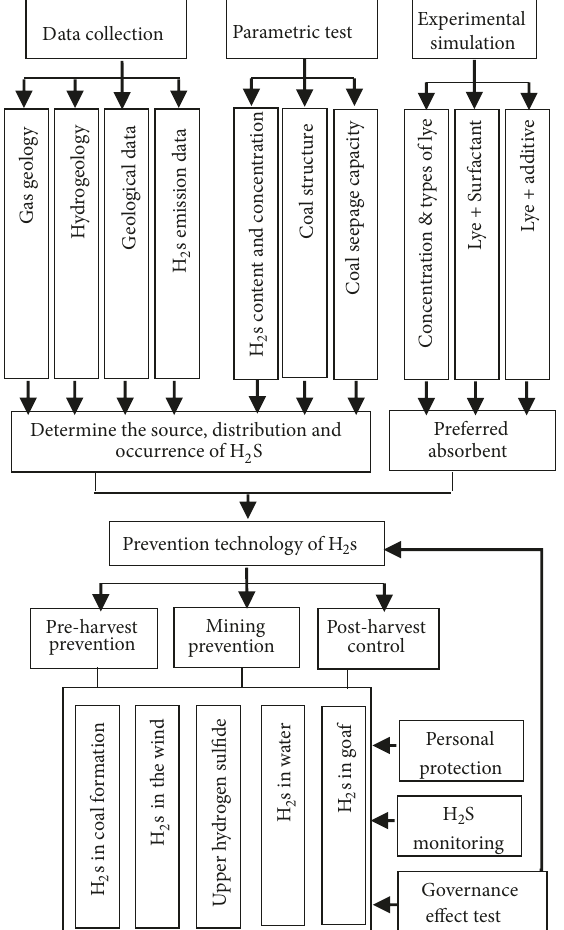
Figure 19: Complete set of technical systems of comprehensive prevention and control technology of H 2 S in coal